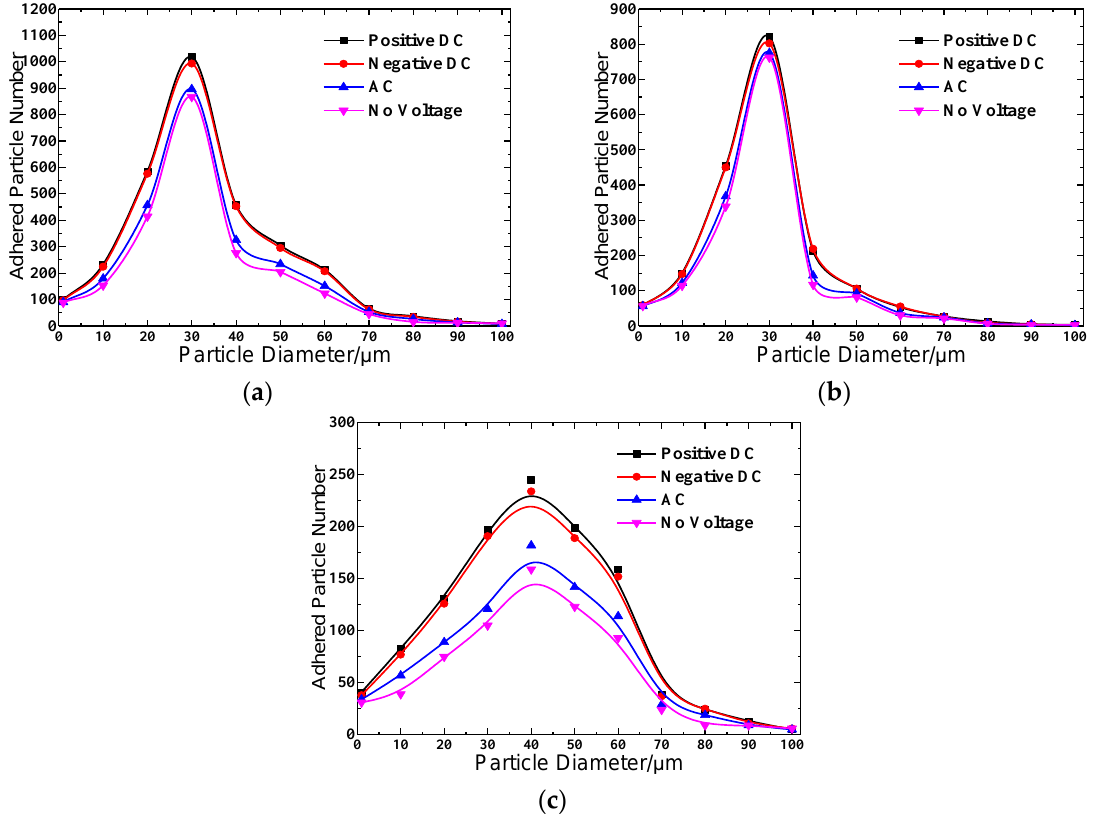
Figure 7. Adhesion number of particles with different size under different electric field types: ( a ) all surface; ( b ) upper surface; and ( c ) bottom surface. surface; ( b ) upper surface; and ( c ) bottom